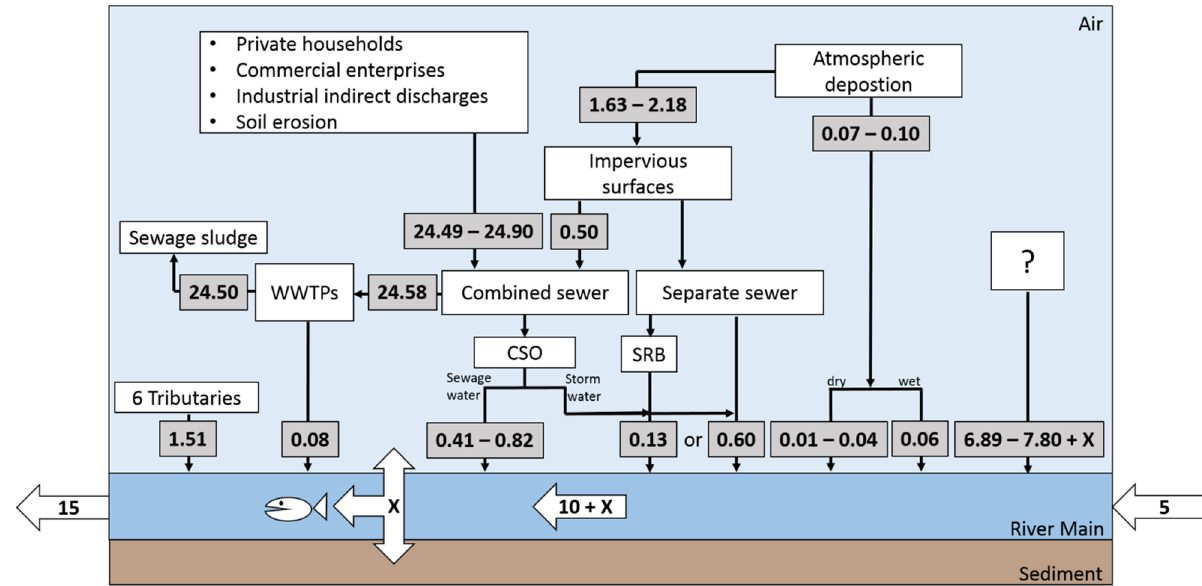
Figure 4. Mass balance of Hg in the water cycle in the study area of Frankfurt am Main. Loads, represented by the numbers in the diagram, are given in kg/a. CSO = combined sewer overflow, SRB = stormwater retention